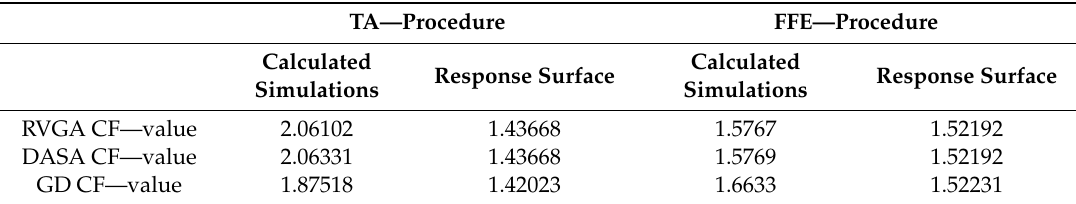
Table 10. Comparison of the cost-function values between the modelled and the calculated.